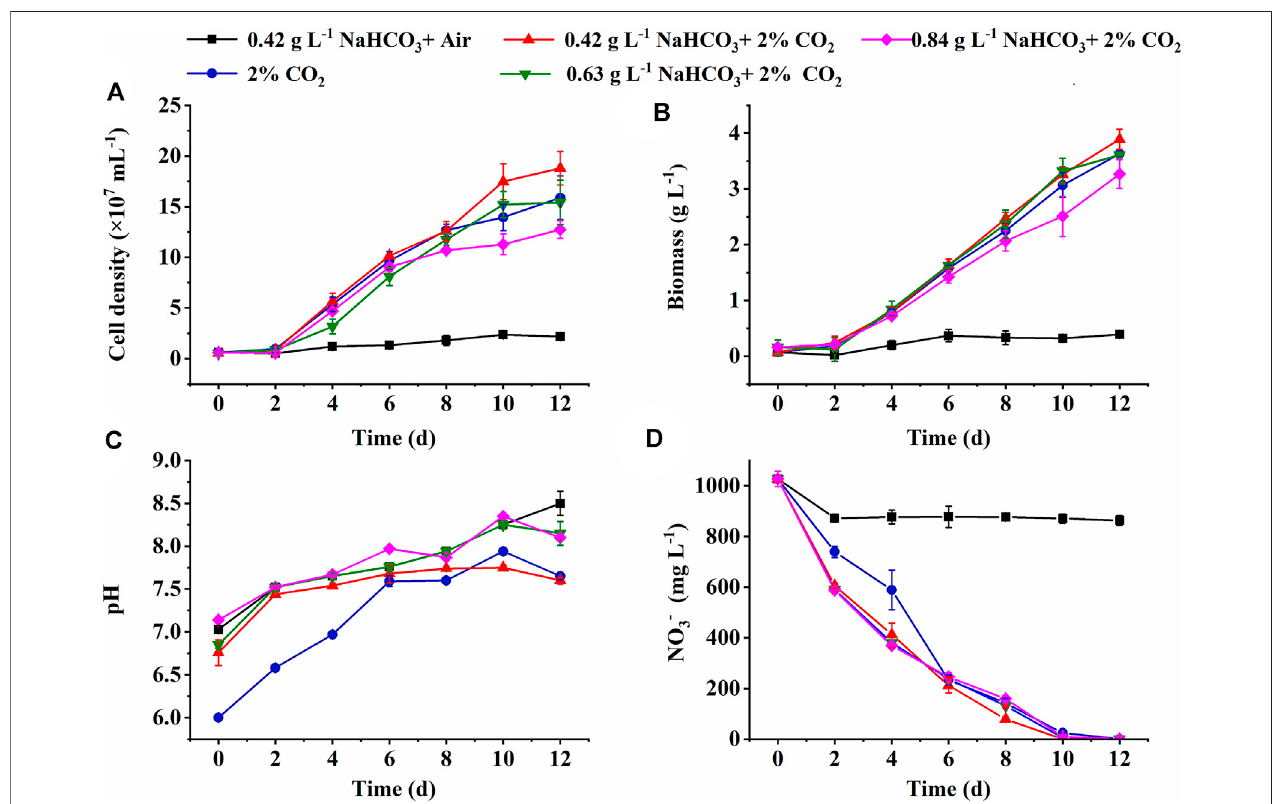
FIGURE 1 | Effect of inorganic carbon source on the cell growth (A) , biomass production (B) , pH changes (C) , and NO 3 − consumption (D) in the medium by autotrophic C. subellipsoidea in shake fl asks.